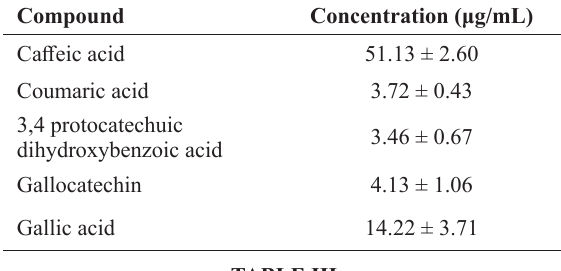
HPLC analysis of phenolic compounds (µg/mL, dry weight) in ethanolic extracts of Hibiscus acetosella . Values are expressed as means ± standard deviations.